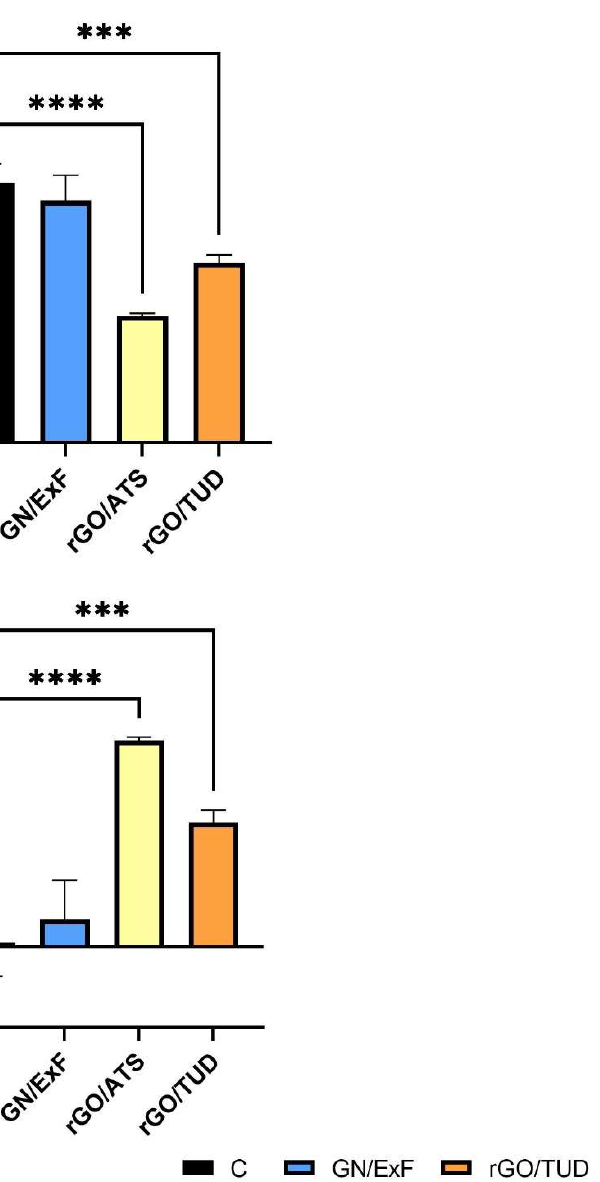
Figure 4. Analysis of U87 and Hs5 cell motility (μm/s) and percentage of motility inhibition (%) in co-culture treated with graphene (GN) and reduced graphene oxide (rGO). Statistical significance between the control and treated cells is indicated by an asterisk and was assessed using Bonferroni’s multiple comparisons test. Differences with p < 0.05 were considered statistically significant. One asterisk (*) indicates p < 0.05, three asterisk (***) indicates p < 0.001 and four asterisk (****) indicate p < 0.0001. Abbreviations: rGO, reduced graphene oxide; GN, graphene; C, control group (untreated group); ExF, exfoliation; ATS, ammonium thiosulfate; TUD, thiourea dioxide. Notes: Cell mobility data were analyzed from three independent cultures. Within each co-culture, 100 cell pathways were analyzed in ImageJ using the TrackMate overlay. The average track duration and distance traveled were obtained from the 100 paths. Three independent means from 100 paths were used for statistical calculations.